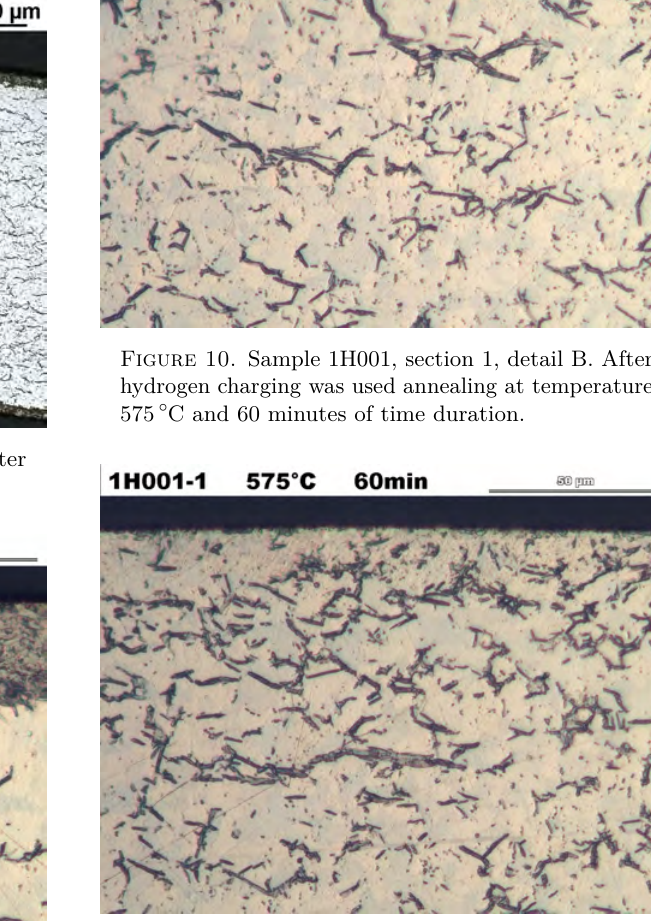
Figure 11. Sample 1H001, section 1, detail A. After hydrogen charging was used annealing at temperature 575 ◦ C and 60 minutes of time